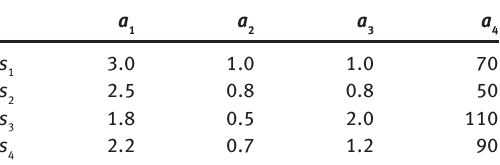
Table 1. Decision Information about Robots.